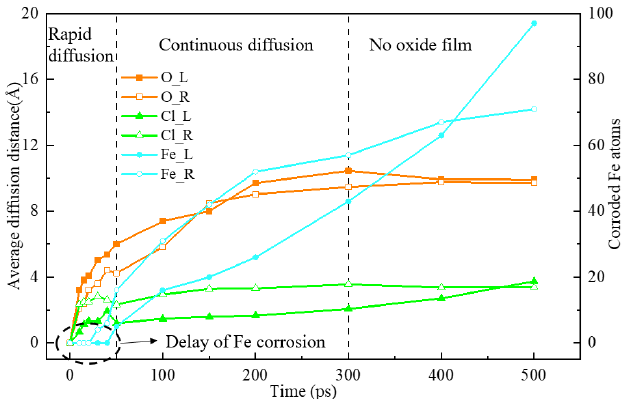
Figure 6. Average diffusion distance of elements and number of corroded iron atoms in model B. L